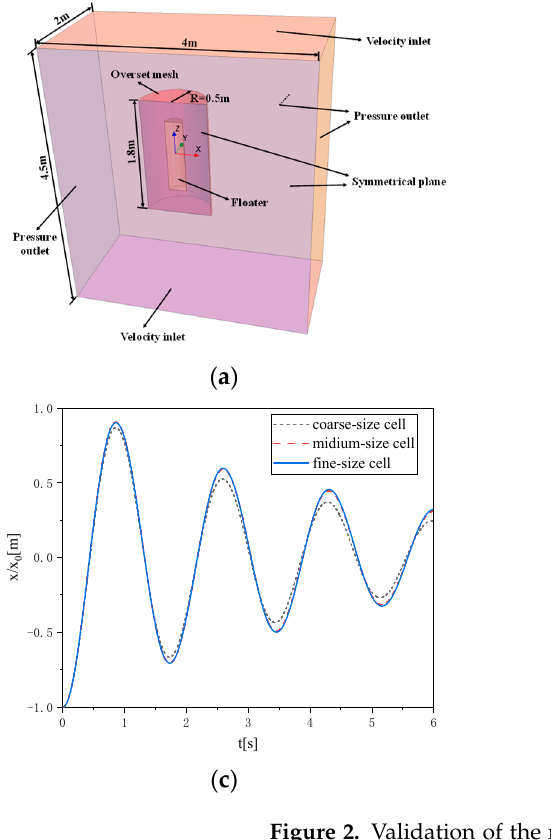
Table 2. Basic parameters for viscosity correction of floaters with different radii. Radius (m) Quality (Kg)